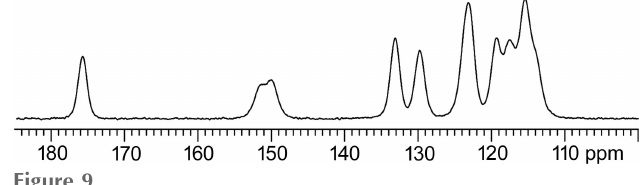
Figure 9 13 C (150.9 MHz) CPMAS SSNMR spectrum of DFQ acquired at a spinning speed of 20